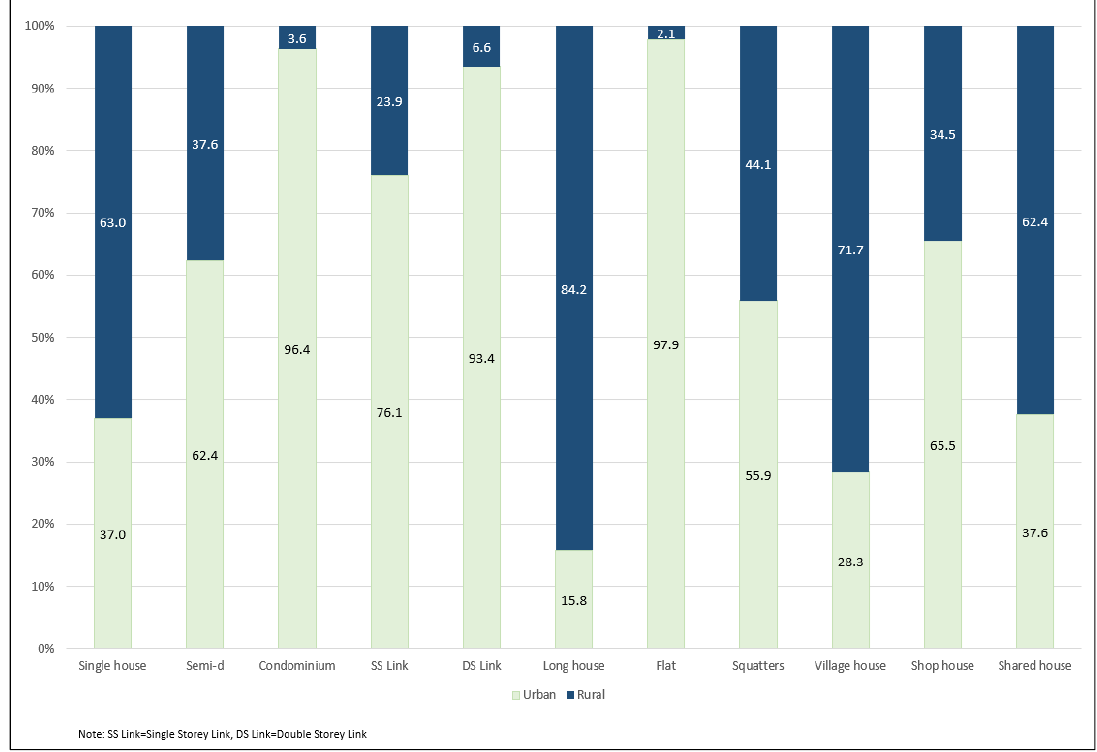
Figure 1. Proportion of house type by geographical location.